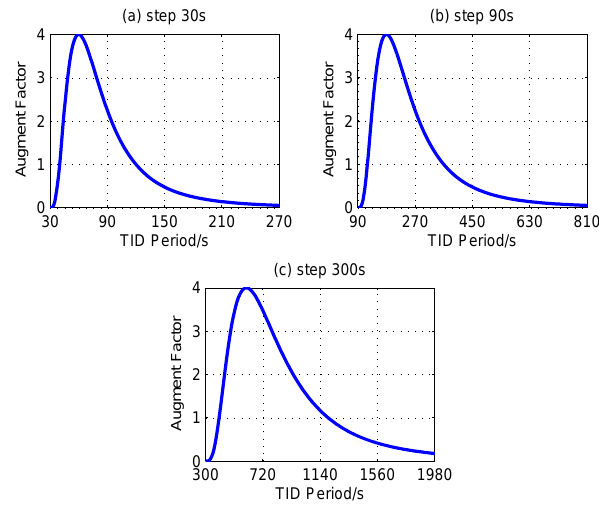
Figure 1. Amplification factors of TIDs for different time